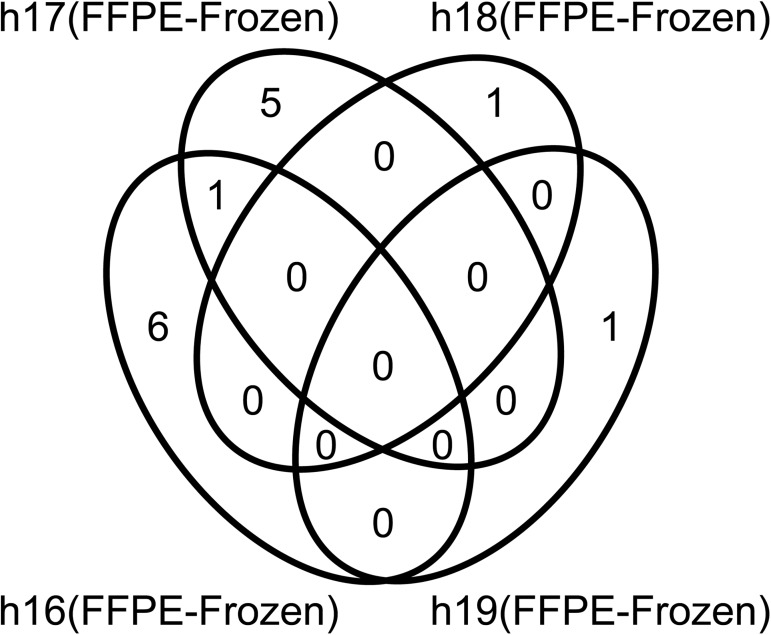
Venn diagram of variant candidates found in 4-pair analyses of FFPE and frozen tissue DNA.Variants identified in 4 matched FFPE-frozen pairs of normal liver tissues, h16, h17, h18 and h19. Fourteen variants were identified by pair analysis using Ion Reporter version 5.0 with the following filters: coverage more than 100, allele frequency more than 0.05, frozen allele coverage = 0. ERCC2 was a common variant among two samples, h16 and h17.